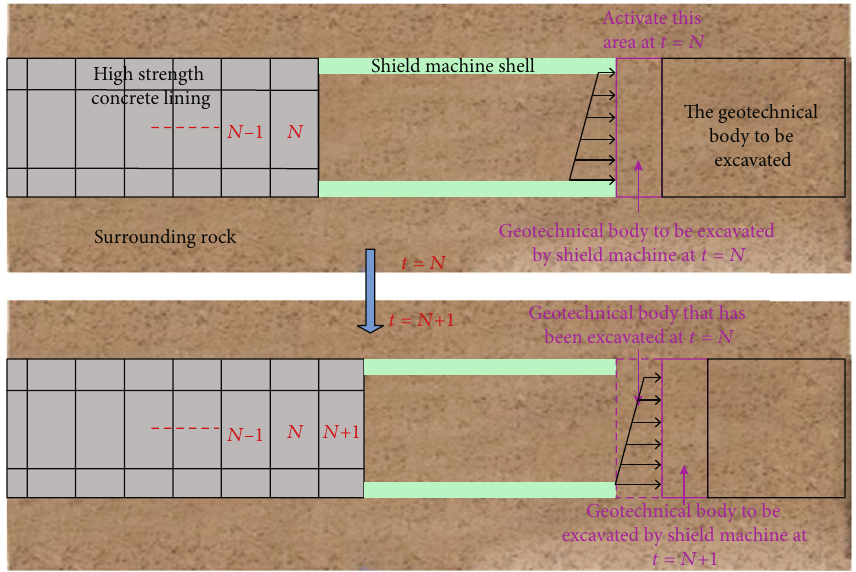
Figure 7: Simpli fi ed schematic diagram of shield excavation process.